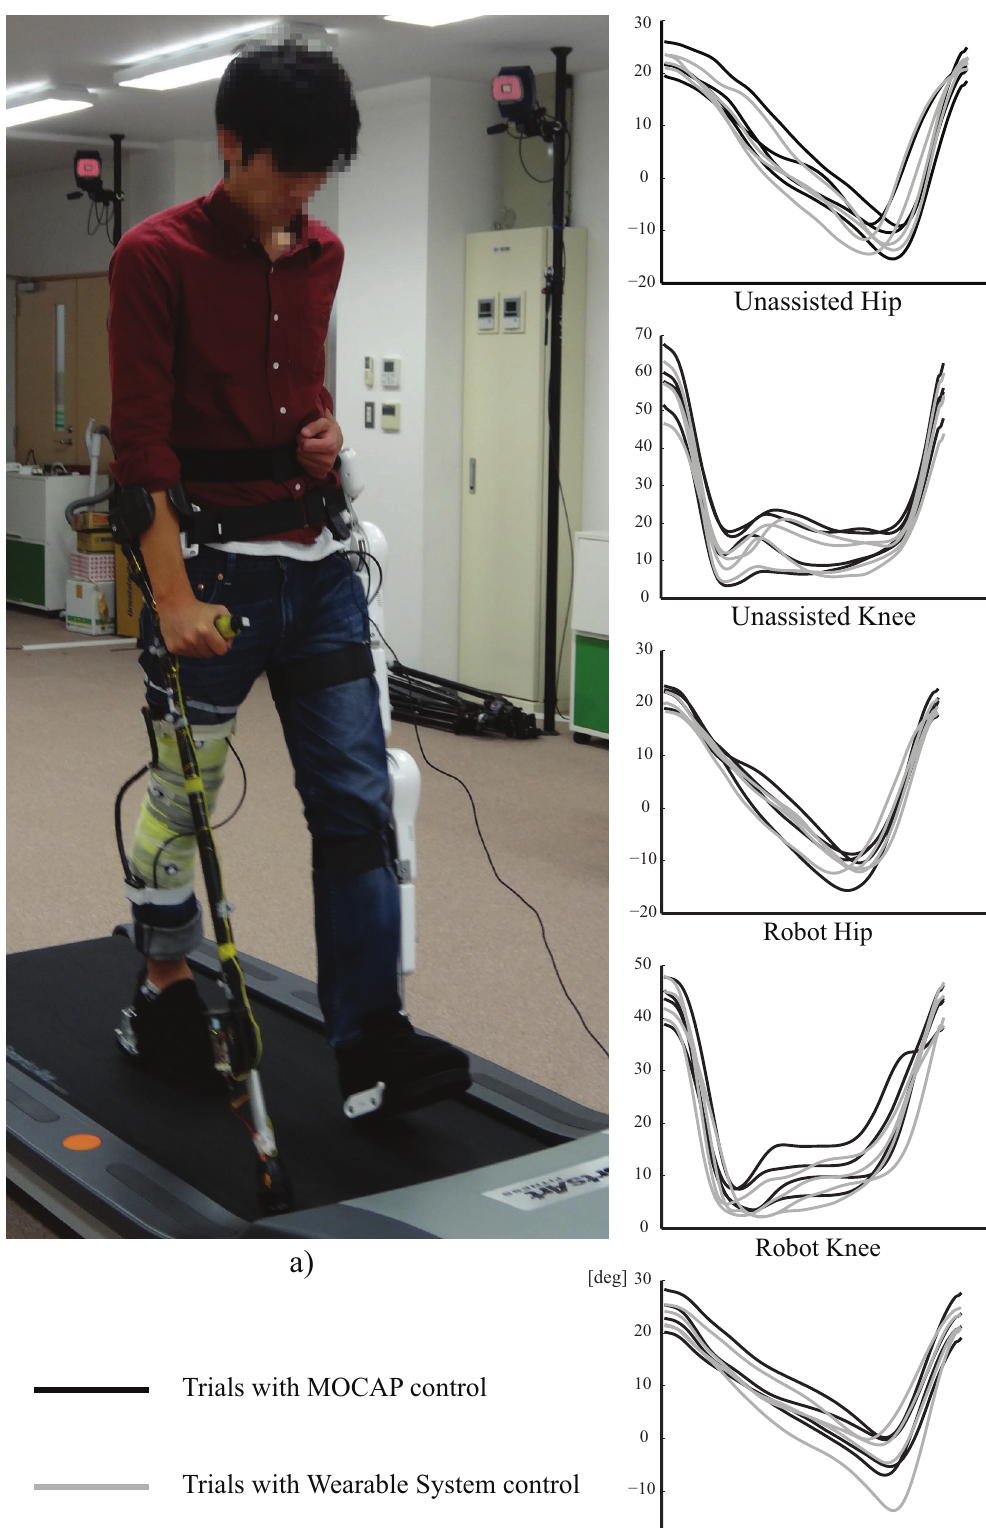
Figure 6. Experimental setup and average trajectories for all